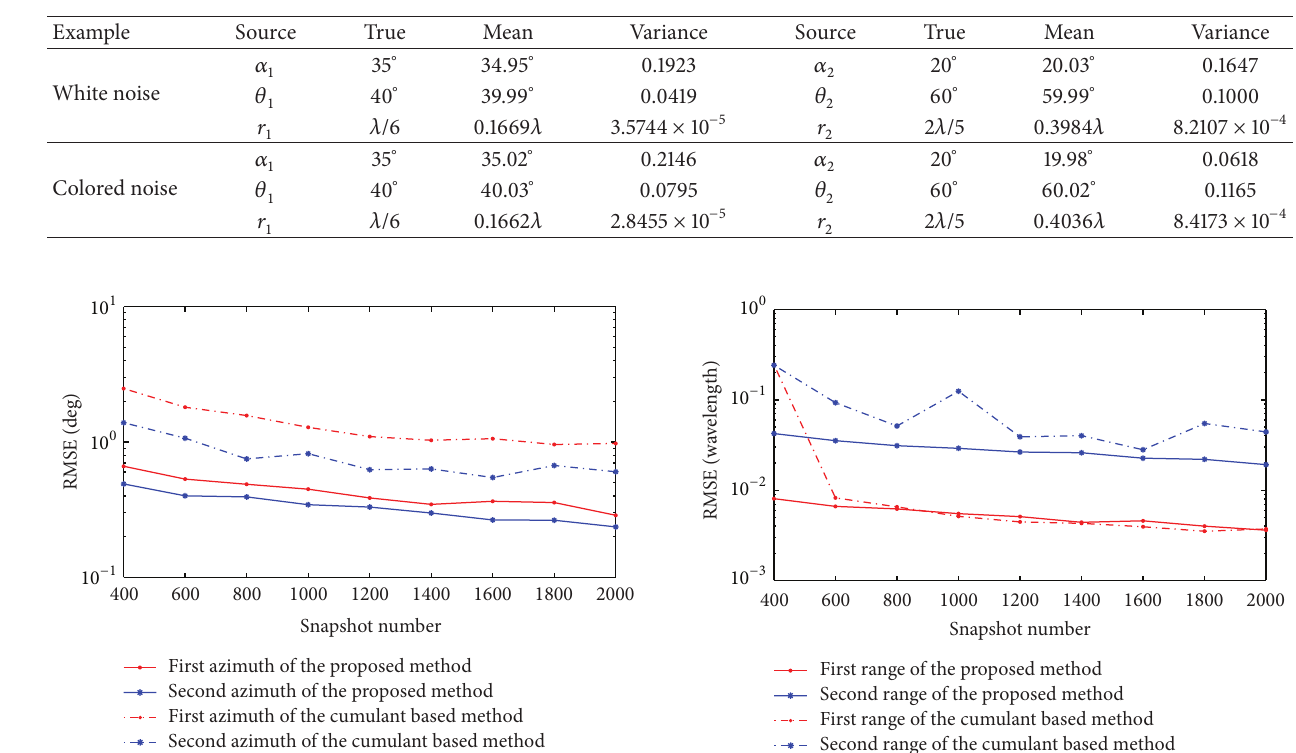
Table 1: RMSE of 3D parameters for near-field localization in the third example.